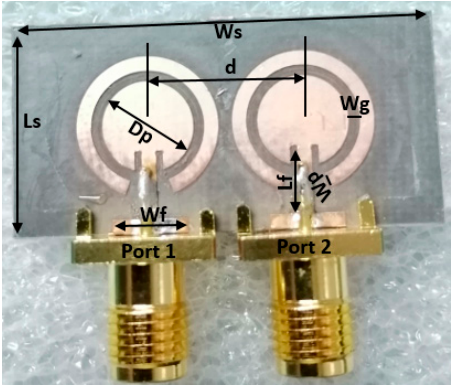
Table 2. Antenna parameter.